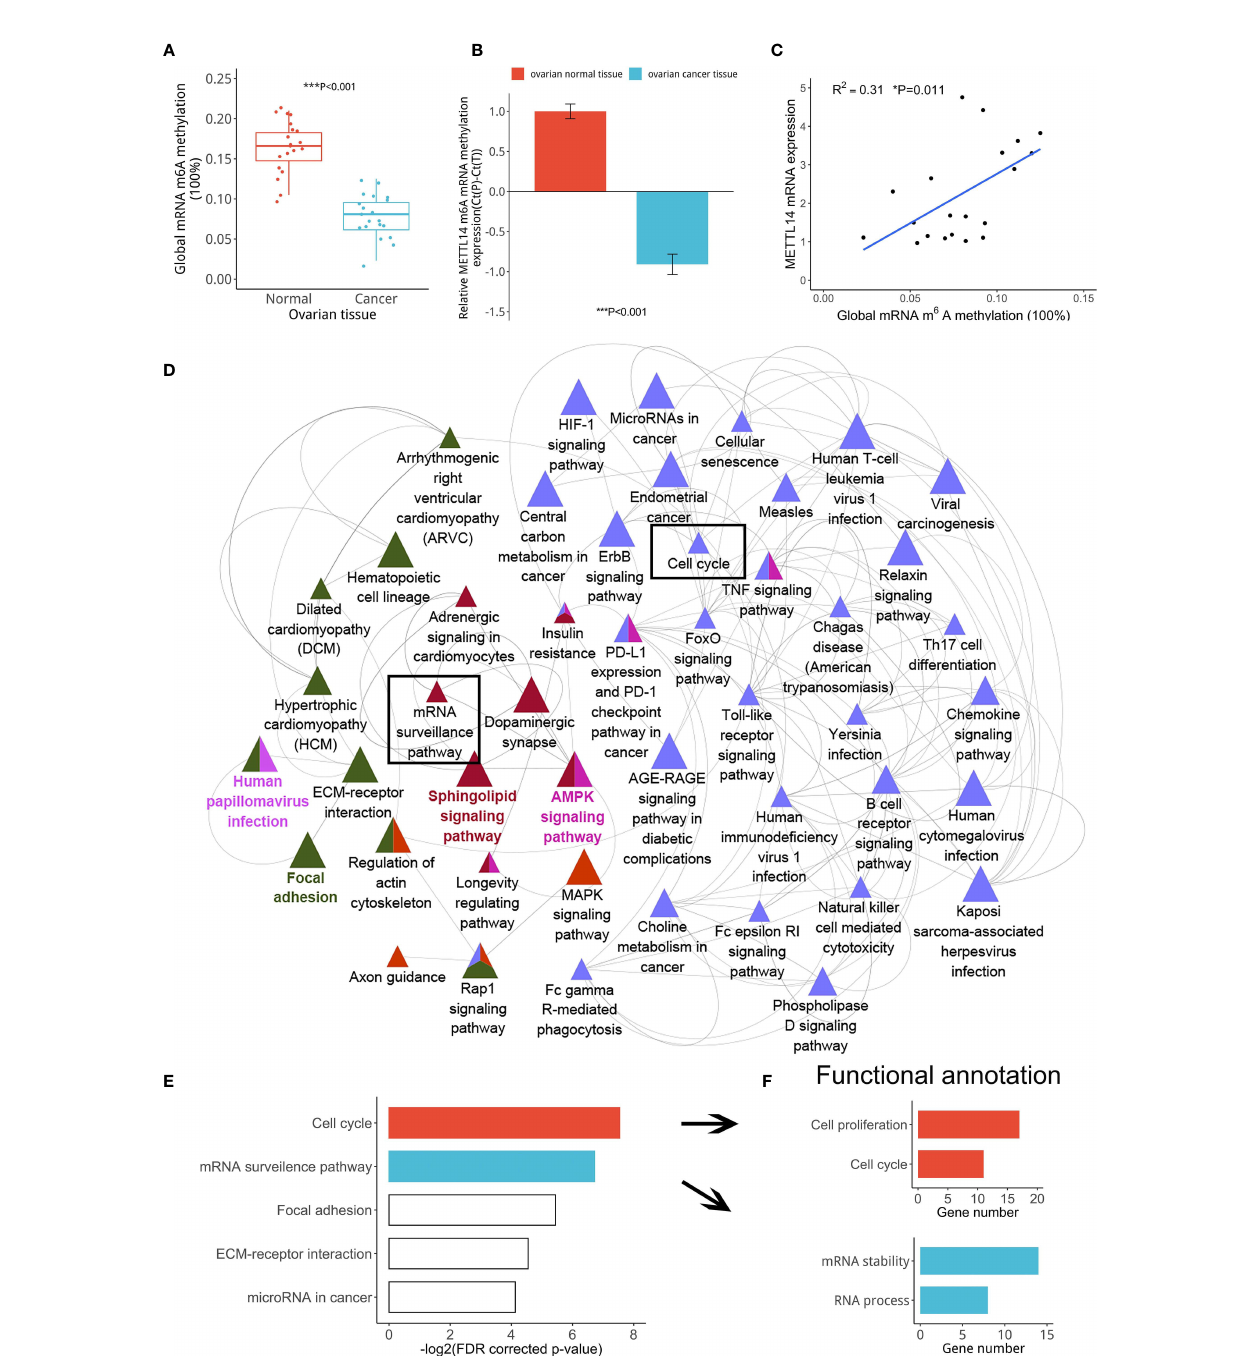
FIGURE 2 | Correlation among reduced METTL14 expression and ovarian cancer cell proliferation. (A) Global mRNA m 6 A methylation levels from ovarian cancer or normal tissues (*** P < 0.001). (B) MeRIP-seq data showing the METTL14 mRNA levels in the GEO database (GSE119168) with the RNA probe (ID: 118685469) (*** P < 0.001). (C) Global mRNA m 6 A methylation levels of ovarian cancer tissues were found to be associated with METTL14 mRNA levels (* P = 0.011). Graphical data represented as the mean ± SD. (D) Pathway enrichment analysis using the ClueGO and CluePedia plugins found in the Cytoscape software. Cluster analysis showing the most enriched pathways according to the m 6 A RNA methylation expression levels using the GSE119168 data. (E) Classi fi cation of the gene categories from cluster analysis mainly included the cell cycle, mRNA surveillance pathway, and related signaling pathways. (F) KEGG gene functional annotation analysis using DAVID classi fi ed the gene categories and signaling pathways from two biological